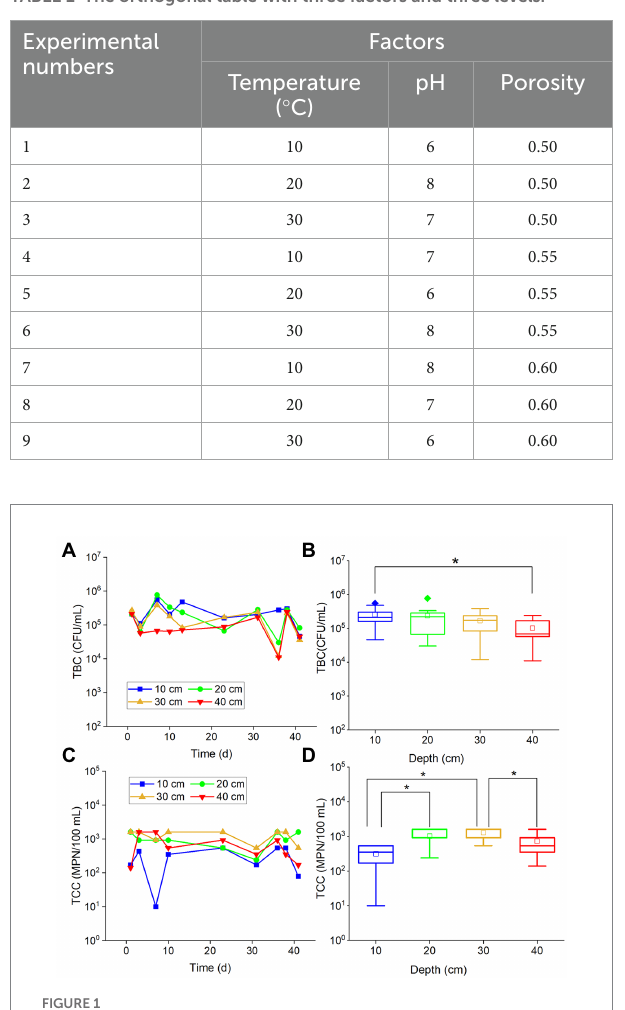
FIGURE 1 The variations of TBC and TCC with (A,C) time and (B,D) depth. The star (*) stands for there was a significant difference between the two concentrations ( p < 0.05). Different colors stand for different depths. The central line and square of each box are the median and mean values, respectively, while the top and bottom of each box represent the third and first quartile, respectively. Whiskers on the box plot represent maximum and minimum values, while rhombuses above or below the box plots show outliers in the